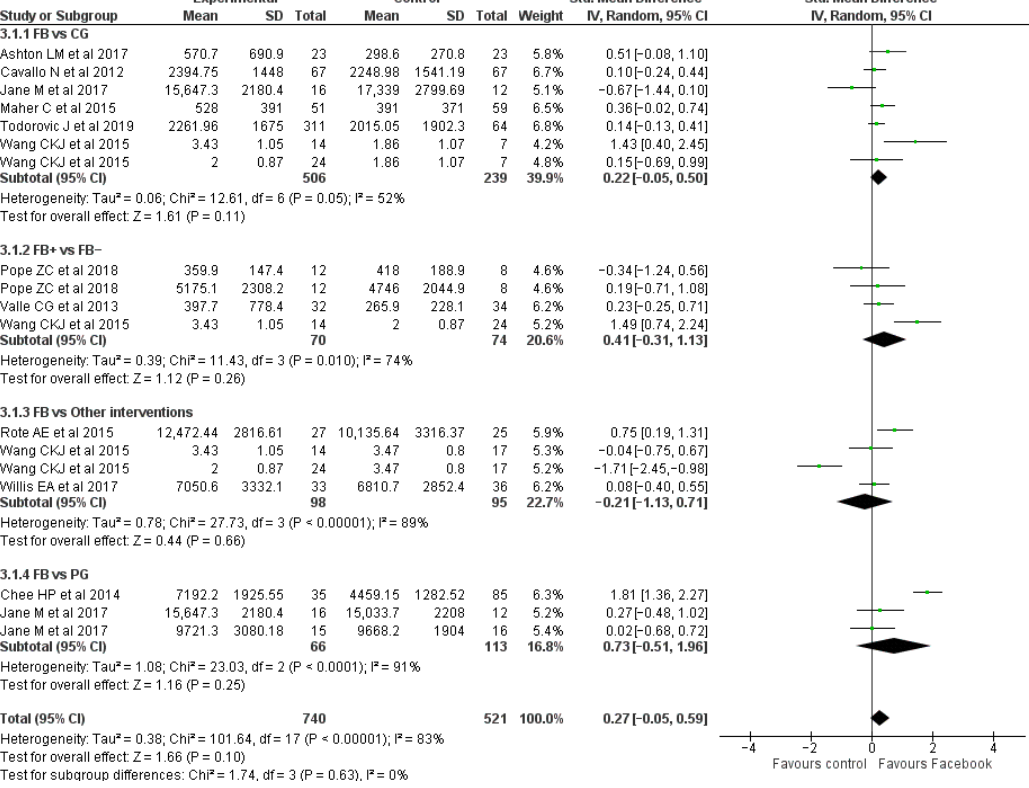
Figure 2. Forest plot representing effect size of FB intervention and control, paper and other groups in total amount of physical activity. FB: Facebook group; CG: control group; PG: paper group; FB+: Facebook with other supports; FB − : Facebook without support.